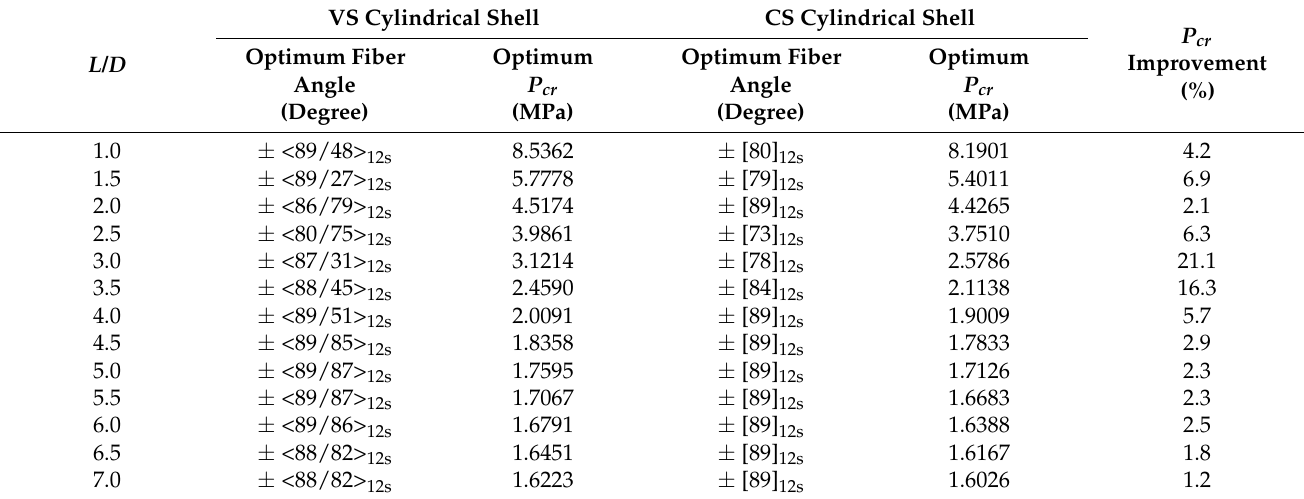
Figure 11. Effect of different defects on P cr . Table 3. The optimum P cr for the VS and CS cylindrical